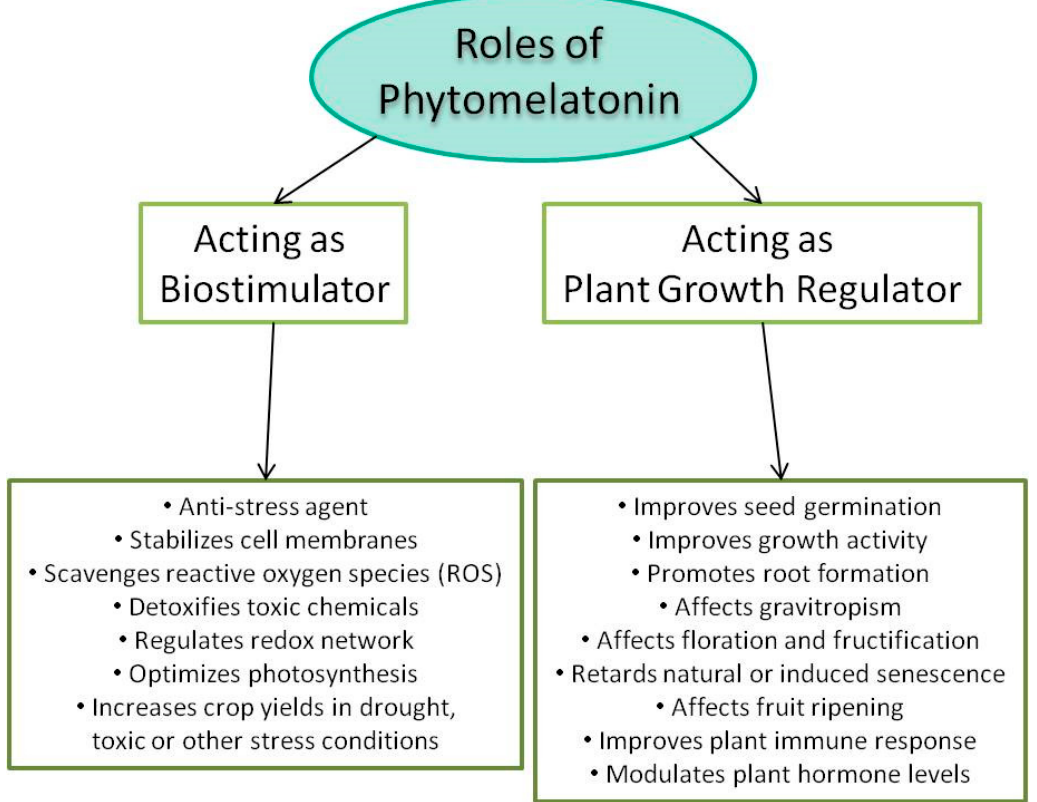
Figure 2. Studied roles of phytomelatonin in plant physiology.